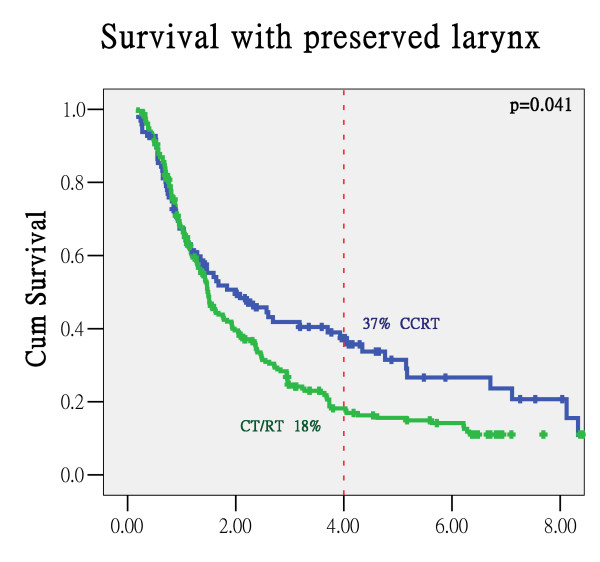
Survival with larynx preservation curve in the organ preservation group.